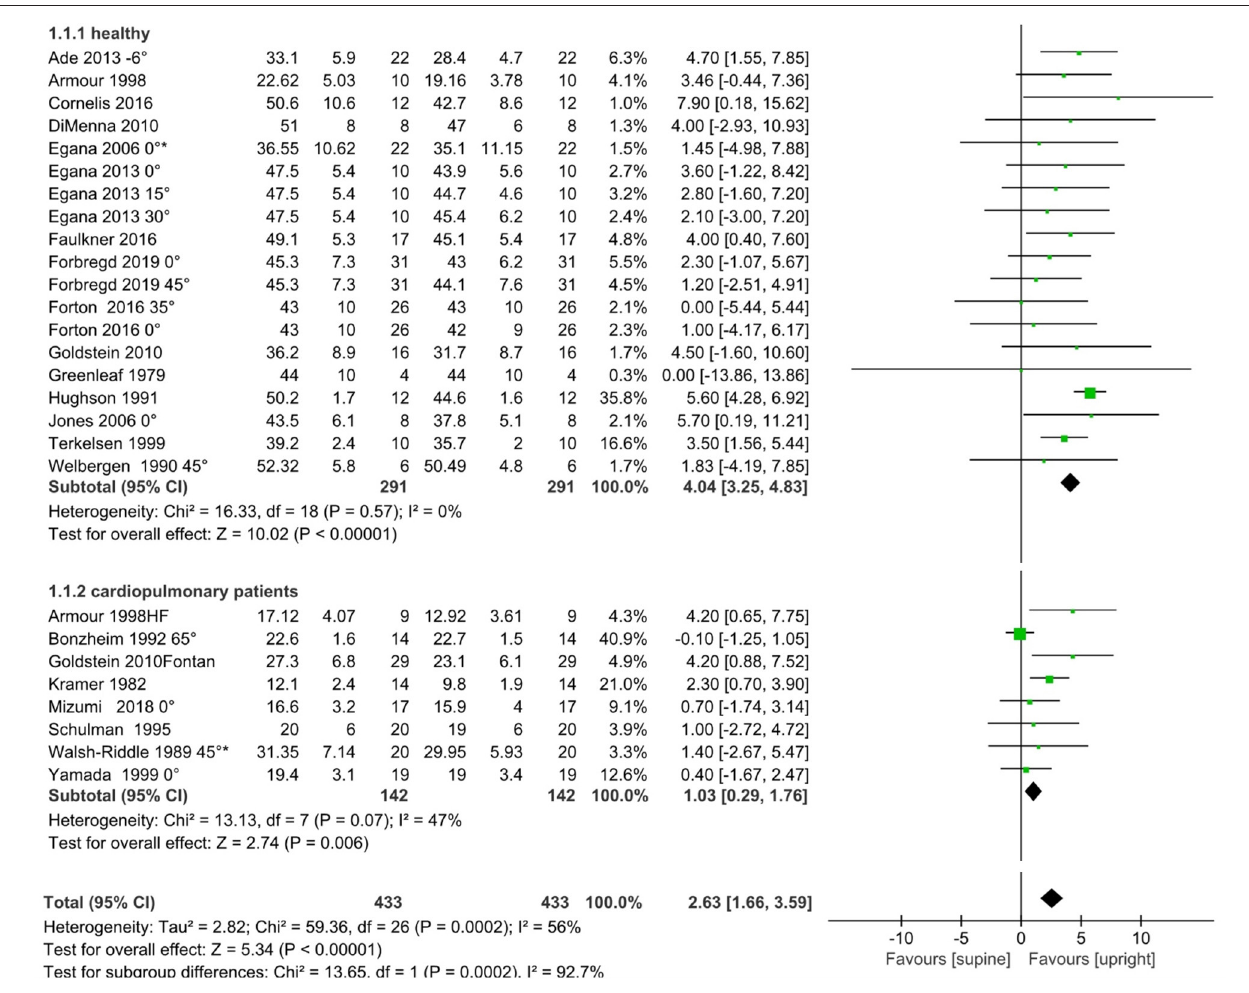
FIGURE 2 | Meta-analysis results for relative VO 2peak (ml/kg/min), including overall pooled effects and subgroup effects of the healthy and the cardiopulmonary disease patients. HF, heart failure; Fontan, Single Ventricle Receiving Fontan Palliation. A degree ( ◦ ) symbol after the reference refers to the angle between upper body and horizontal plane in the supine position. A reference without a degree indicates that the details were unavailable in the original text. An asterisk means that the original text’s grouping data are combined according to the formula in Cochrane 7.7, because the angle between the upper body and the horizontal plane is the same as in the supine